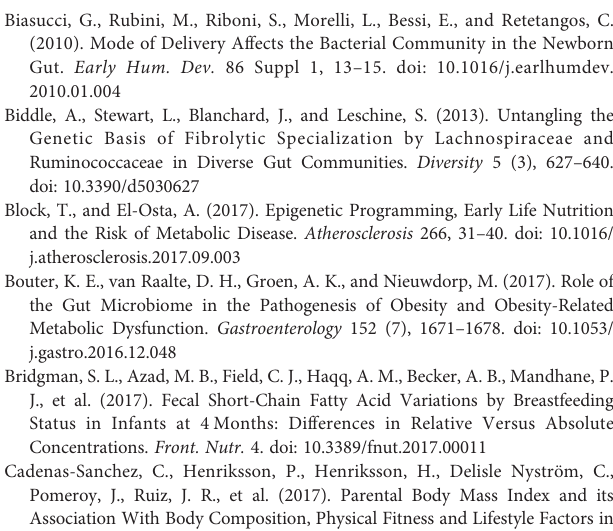
Supplementary Figure 1 | Infographic work of the overall methodology. Supplementary Figure 2 | Redundancy analysis (RDA) highlighting pro fi le drivers. Supplementary Figure3 | Boxplotofdifferentialabundancesofgenerabypro fi le(#1 in blue is driven by Blautia ; #2 in red is driven by Prevotella ). Adjusted p-value <0.05. Supplementary Table 1 | Differential abundances of bacteria by pro fi